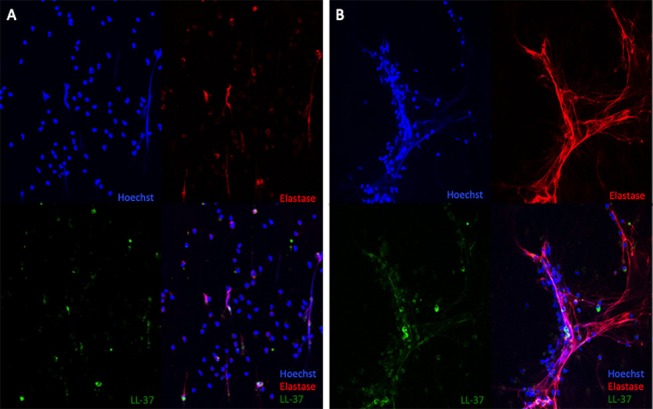
LL37 expression in LPS-induced NETs of a representative patient at baseline (A) and during the infectious process (B). 40X.